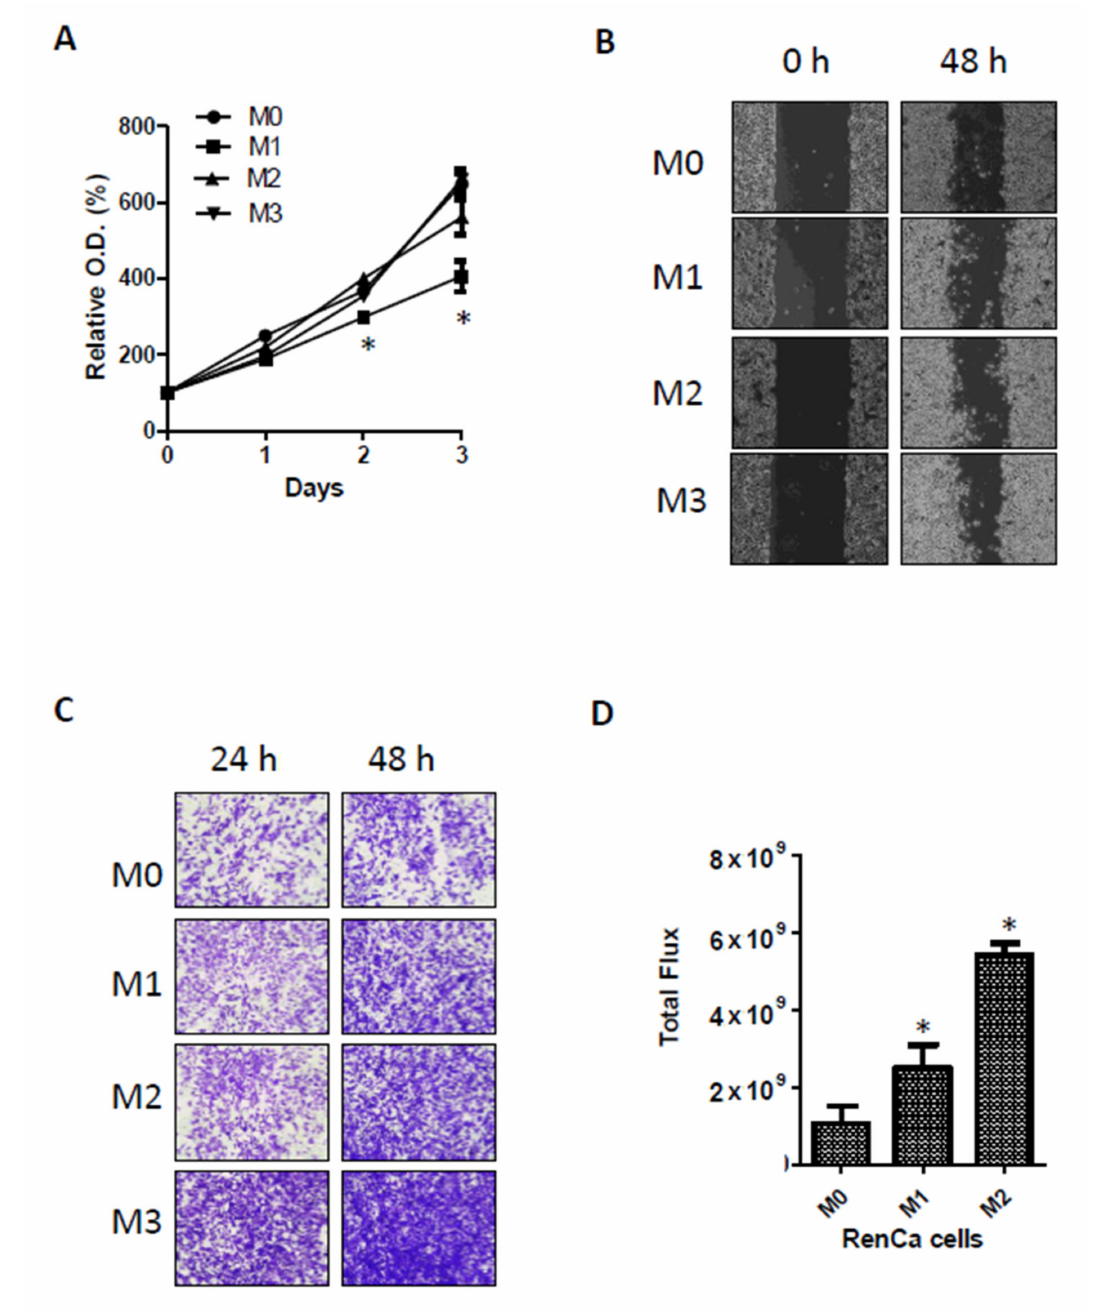
Figure 5. Characteristic of metastatic prone RenCa cells. ( A ) Cell growth rate of original RenCa (M0) and metastatic RenCa (M1–M3). Time dependent viability changes of M0–M3 RenCa cells were assessed using EZ-Cytox solution. Bars represent the means ± SDs of three independent experiments, and * denotes p < 0.05 (Student t -test) versus the M0 group. ( B ) Scratch-wounding cell migration of the M0–M3 RenCa cells were observed after indicated time. ( C ) The trans-well infiltration assay of the same number of indicated RenCa cells. At indicated time after plating, cells that had migrated to the underside of the filters were fixed, stained with crystal violet and photographs were taken. ( D ) Bioluminescent flux plot from the live mice injected with M0-M2 after 14 days of injection. Error bars represent means ± SEM of each group ( n = 3). * p < 0.05 (Student’s t -test) versus the M0